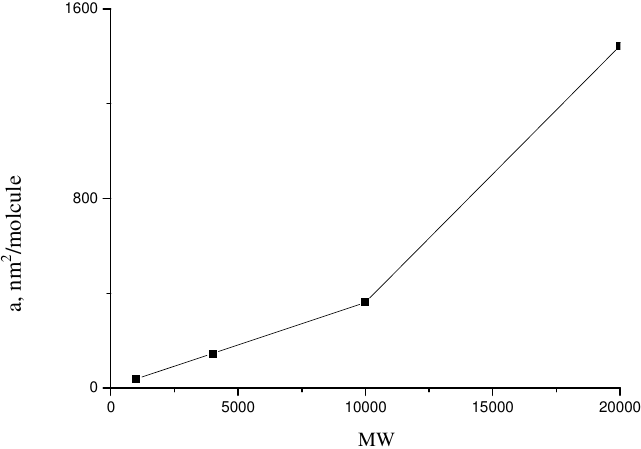
Figure 2. Relationship between PEG MW and molecule area